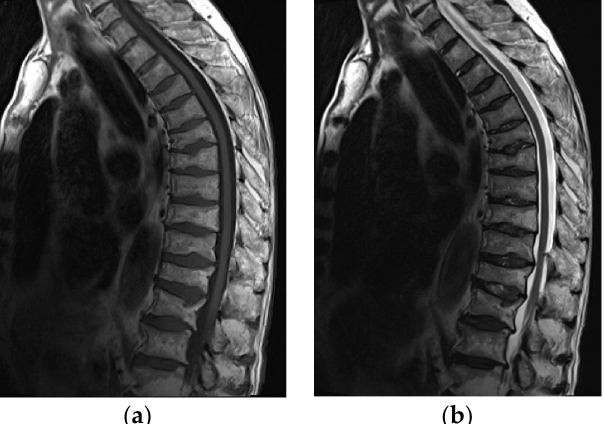
Figure 11. MRI of the spine in a 61-year-old patient with systemic lupus erythematosus with multiple compression fractures. ( a ) Sagittal T1-weighted and ( b ) T2-weighted Time Spin Echo MR images of the thoracic spine show a loss of height in nearly all thoracic and L1 and L2 vertebral bodies without significant bone marrow edema in ( b ). This is consistent with chronic compression fractures with associated disc dehydration and marginal endplate osteophytes, but without significant